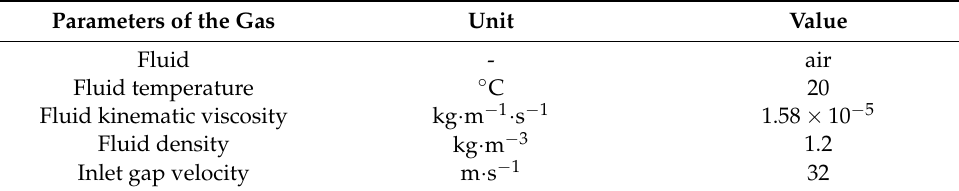
Table 1. Gas properties for the CFD